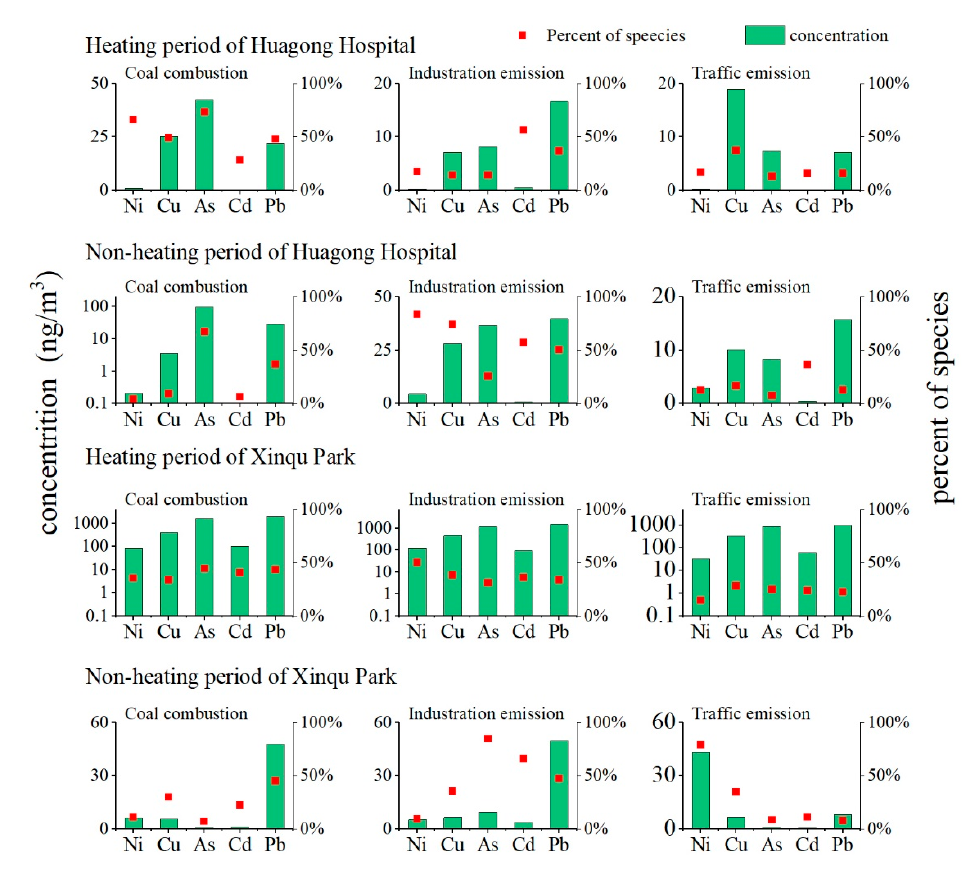
Figure 3. Source profiles and percentage contributions of heavy metals in PM 2.5 by PMF.